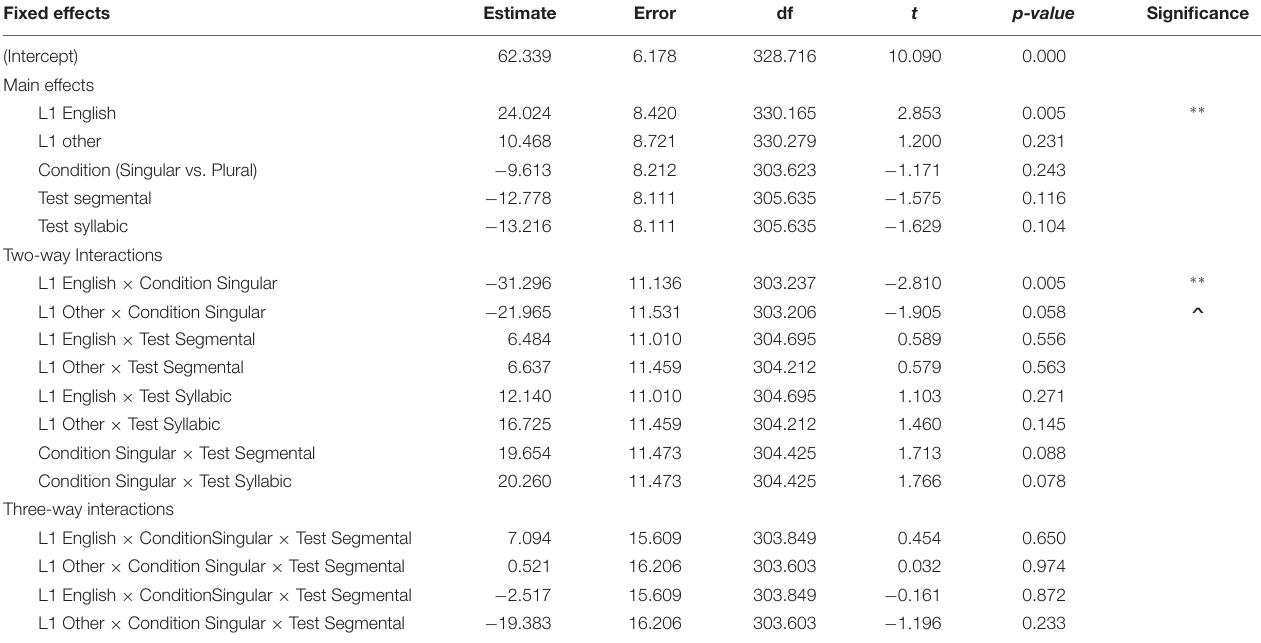
TABLE 4 | Main effects and interaction with estimated